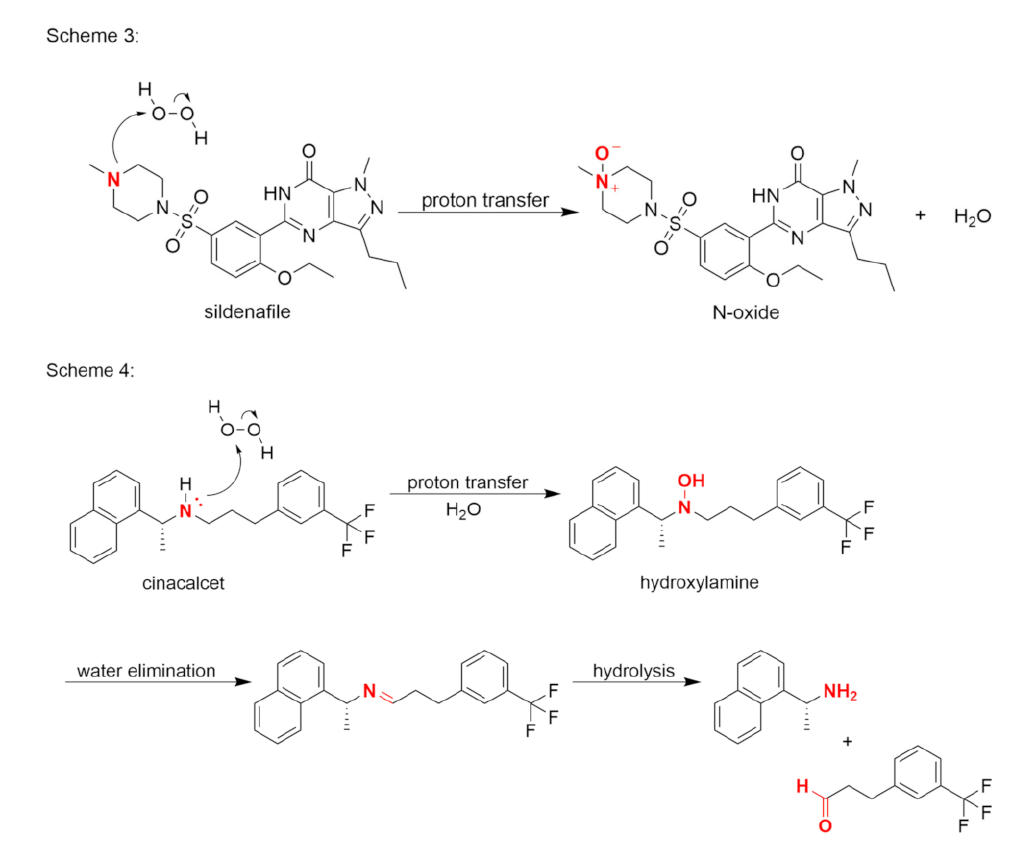
Figure 5. Formation of an N-oxide (Scheme 3) and a hydroxylamine, with hydrolysis (Scheme 4).